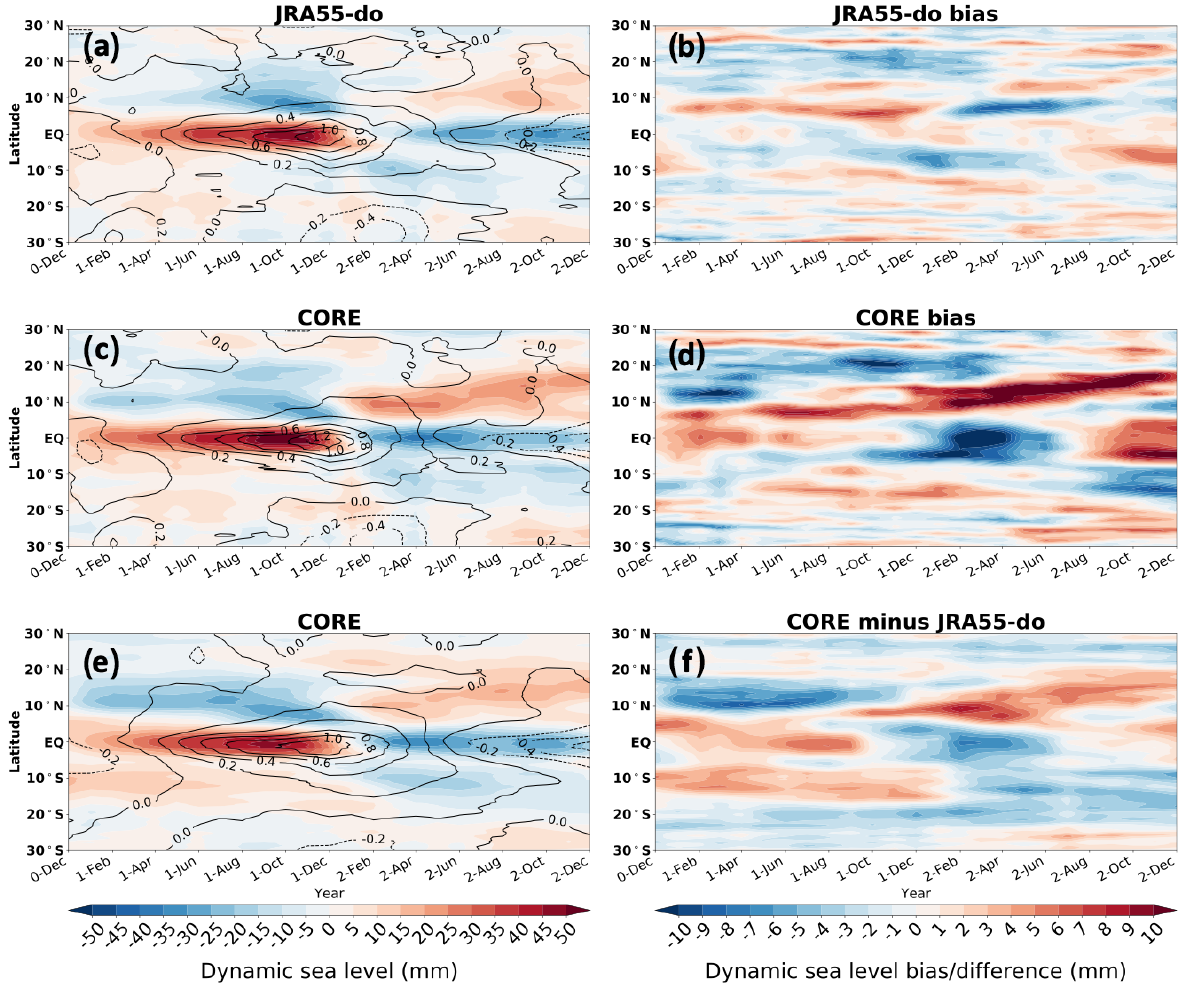
Figure 23. Hovmöller diagram showing the zonal mean over the tropical Pacific basin during the El Niño composite (1993–2007 with a total of four El Niño events) in the (a) JRA55-do-simulated DSL variation (shading), sea surface temperature (contour with unit ◦ C), and (b) the associated DSL bias, and the (c) CORE-simulated DSL variation (shading), sea surface temperature (contour with unit ◦ C), and (d) the associated DSL bias. (e) Hovmöller diagram of the zonal mean over the tropical Pacific during the El Niño composite (1958–2007 with a total of 12 El Niño events) in the CORE-simulated DSL variation (shading), sea surface temperature (contour with unit ◦ C), and (f) the JRA55-do-simulated DSL subtracted from